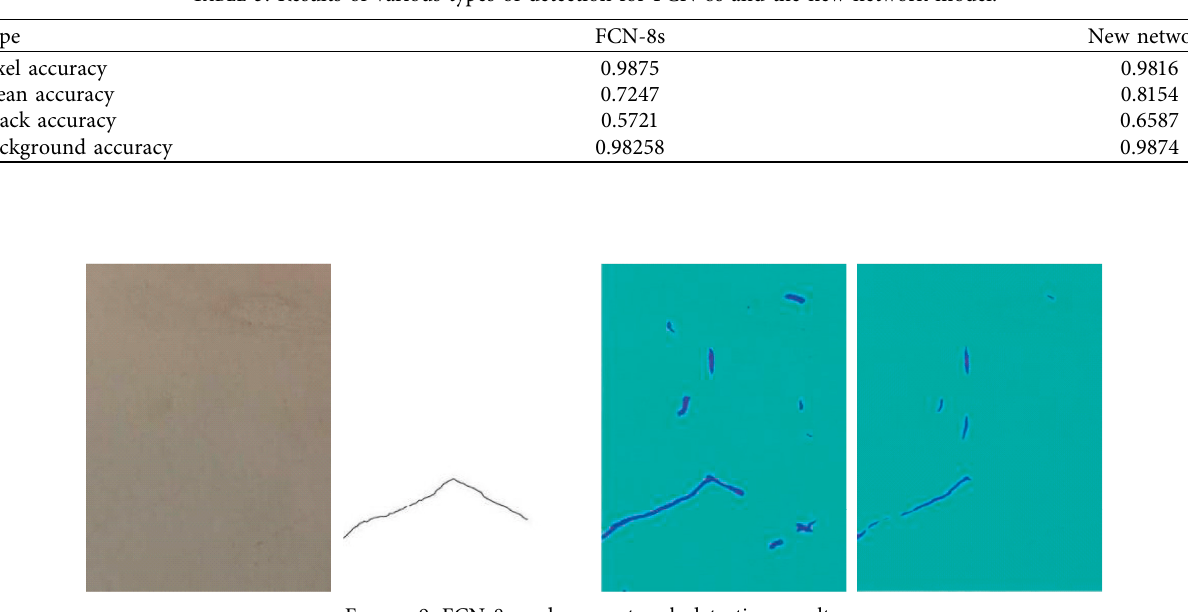
Table 3: Results of various types of detection for FCN-8s and the new network